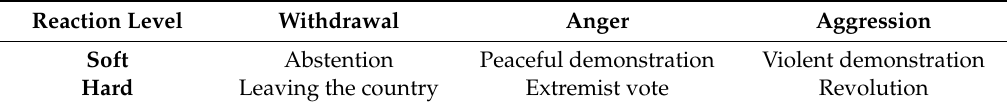
Table 2. Typology of the consequences of democratic